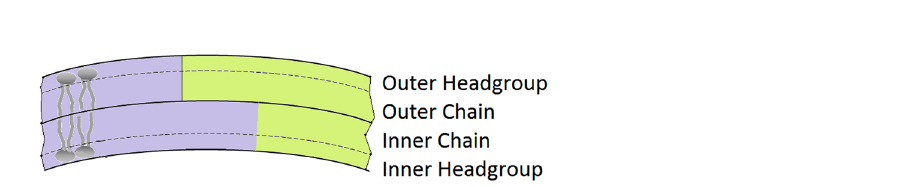
Figure 3. SANS curves in absolute scale ( a ) d54-DMPC: DMPG = 0.75:0.25 and ( b ) d54-DMPC: DMPG = 0.5:0.5 with various P/L ratios: lipid only (black), 1/100 (purple), 1/30 (blue), 1/10 (red).